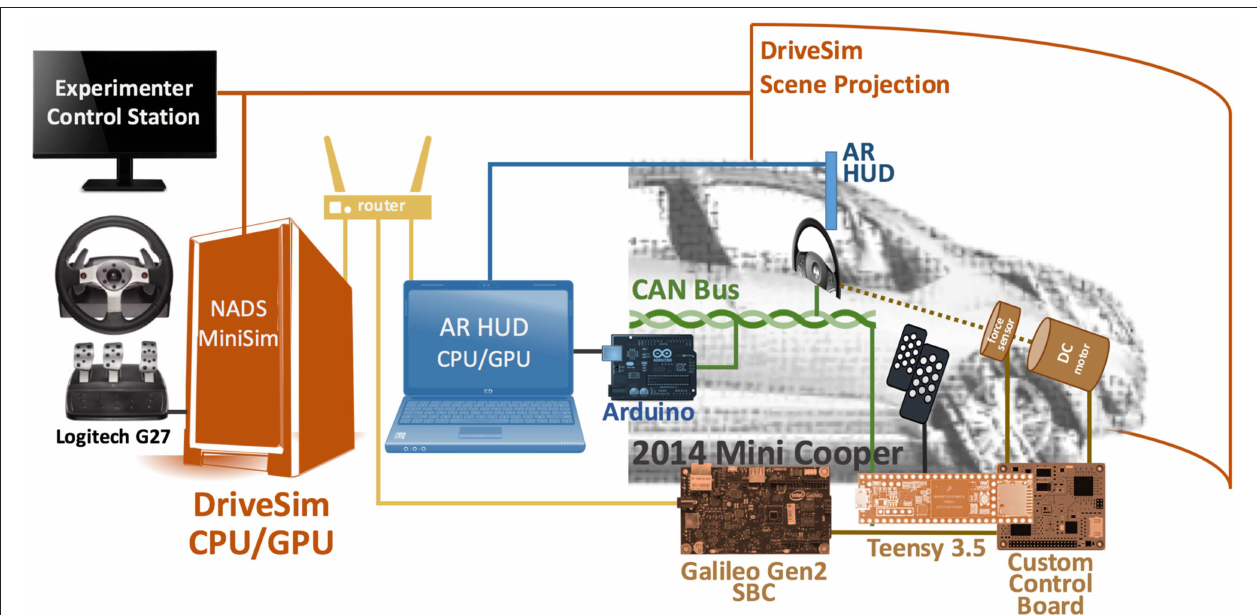
FIGURE 3 | The major computing components of our AR DriveSim communicate via UDP (yellow). A set of off-the-shelf and custom microcontrollers (brown) pass driving control inputs read from CAN bus (green) and other sensors to the AR DriveSim computer (orange). A control board (brown) further manages a DC motor to provide force feedback to the steering wheel. A separate computer (blue) renders 3D graphics on an AR HUD by synchronizing its virtual camera position in real-time with the AR DriveSim computer. A set of experimenter controls (black) assist in coordinating